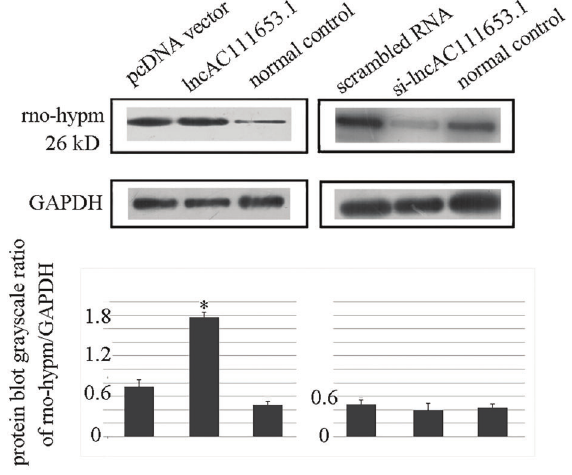
Figure 5. Western blot images. Cells were transfected with pcDNA3.1-lnc-AC111653.1 for overexpression and with siRNA- lnc-AC111653.1 for RNA interference. pcDNA3.1 vector and scrambled RNA served as negative controls. *P o 0.05 compared to the other groups